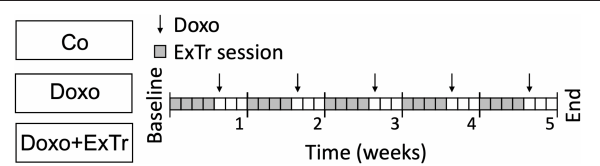
FIGURE 1 | Experimental design. Doxorubicin was administered weekly (5 mg/kg i.p. for 5-wk), concomitantly with low-to-moderate intensity aerobic exercise training (40–50% maximal exercise capacity for 40min, 4 days per week), or follow-up. Co, control ( n = 12); Doxo, doxorubicin ( n = 20); Doxo